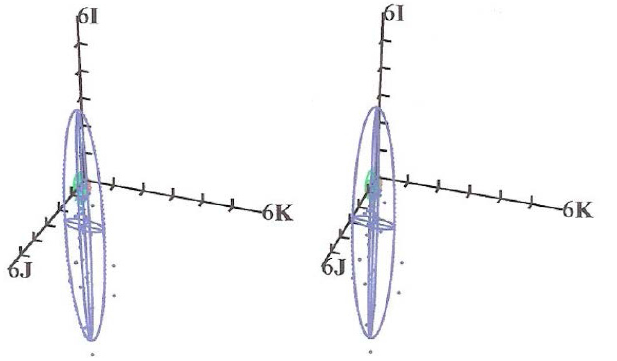
Figure 8: Stereo-pair scatter plot of fifty measurements of refractive state taken from subject 7. The origin of the axes is at 1 I D. Axis length is six dioptres, necessary to place all three ellipsoids on one set of axes. The red and green ellipsoids are partially obscured by the blue ellipsoid and are located near the origin of the axes.